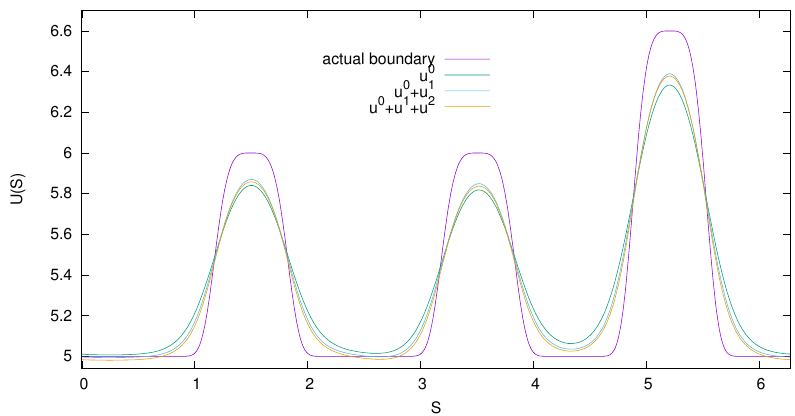
Figure 5. Recovered unknown interior boundary for example 2, w =